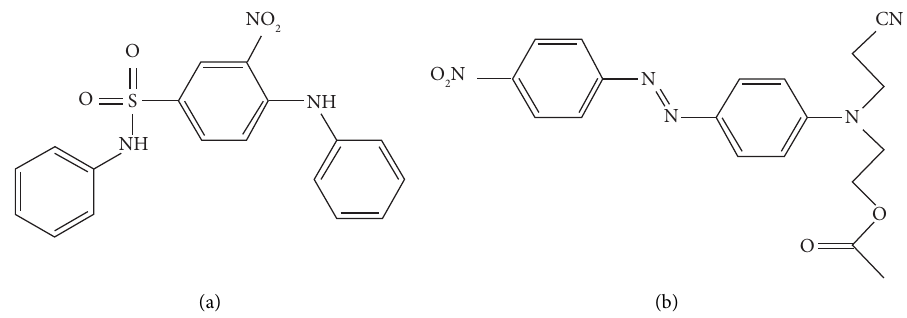
Figure 1: Te structures of diferent dyes used in the experiment (a) Disperse yellow 42, (b) Disperse orange 31. Table 1: Particle sizes of dispersed orange 31 with diferent media diameters and mass ratios. Original sample